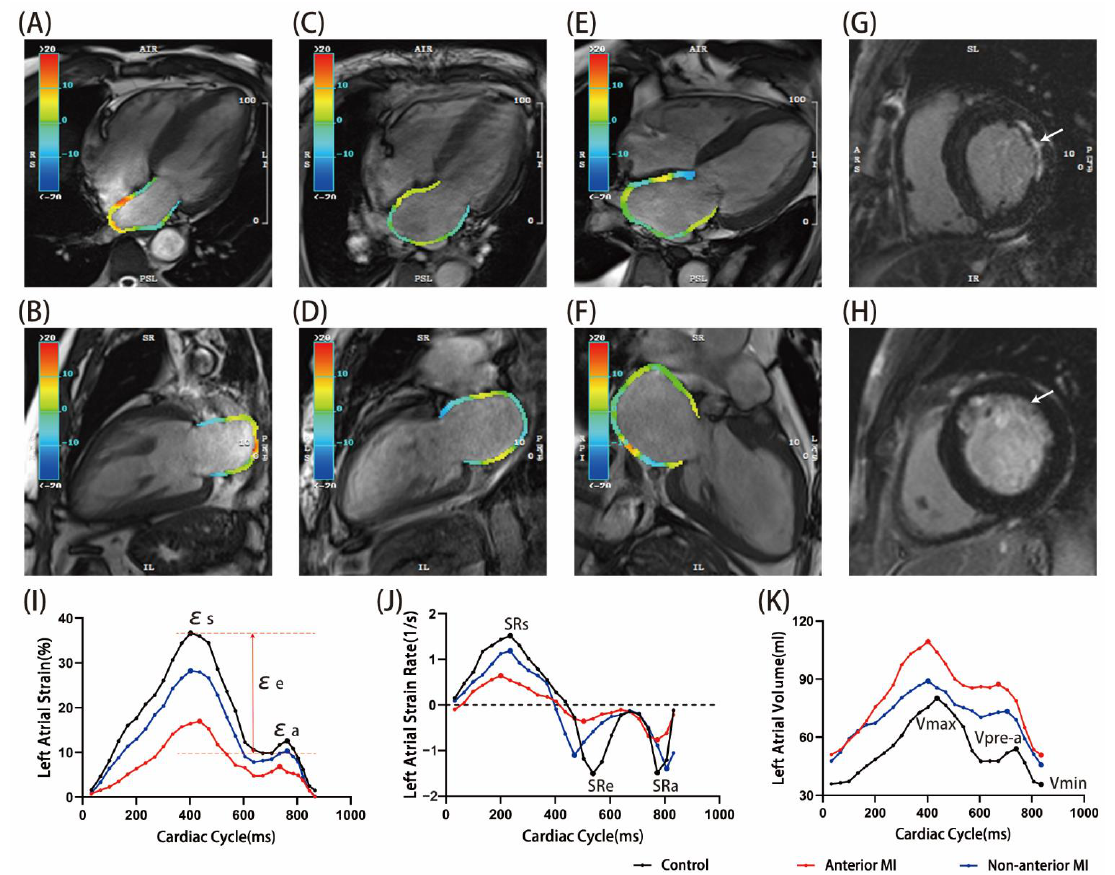
Figure 2. Typical examples of control (( A , B ) and black line), non-anterior MI (( C , D , G ) and blue line) and anterior MI (( E , F , H ) and red line). ( A , C , E ) 4-chamber view of LA systolic phase, ( B,D , F ) 2-chamber view of LA systolic phase (the LA color varies strain parameters). ( G ) = lateral MI, ( H ) = anterior MI. ( I – K ) Curves showing LA strain, strain rate and volume in 25 phases, respectively. MI size was larger in the patient with anterior MI (16.9 v s.10.1%). ε s = t otal strain; ε e = passive strain; ε a = active strain; SRs = total strain rate; SRe = passive strain rate; SRa = active strain rate. 3.3.1. LA Volumetric Parameters LA geometry indices, including LAVImax, LAVIpre-a and LAVImin, were all higher in both anterior MI and non-anterior MI patients compared with healthy controls (all p < 0.05). However, after adjusting MI size, there were no differences in LAVImax, LAVIpre- a and LAVImin between anterior MI and non-anterior MI patients ( p > 0.05, Table 4). Fur- ther stratification of MI size showed that, compared with the controls, LA volumes were increased in both the anterior and non-anterior groups when MI size was >15% but no differences were found when MI size was ≤15% (Figure 3). In the anterior MI group, pa- tients in the MI size >15% subgroup had larger LAVIpre-a and LAVImin than in the MI size ≤1 5% subgroup. In the non-anterior MI group, patients in the MI size >15% subgroup had larger LAVImax, LAVIpre-a and LAVImin than in the MI size ≤1 5% subgroup.